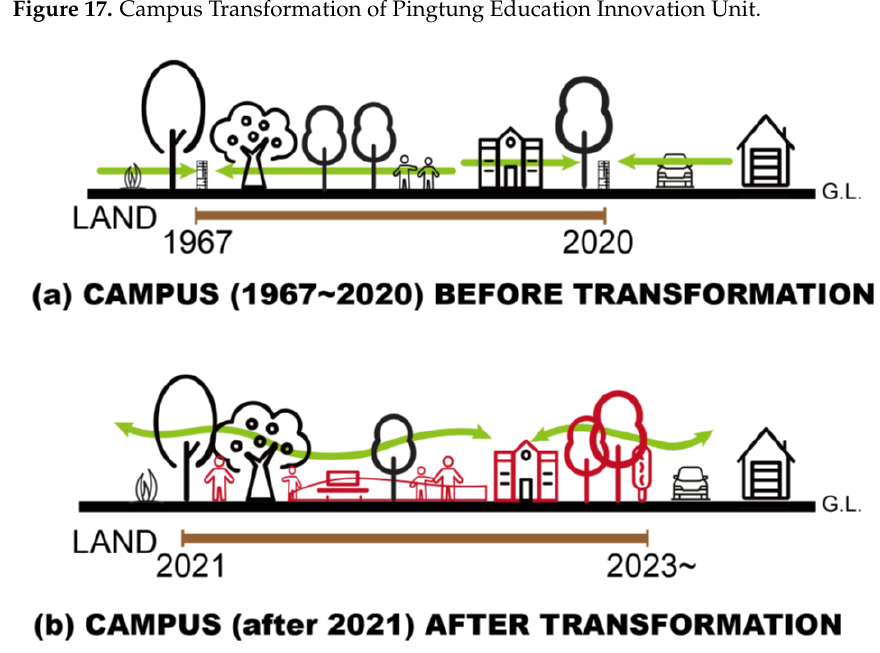
Figure 18. Campus Transformation of Pingtung AI Agri Hub.